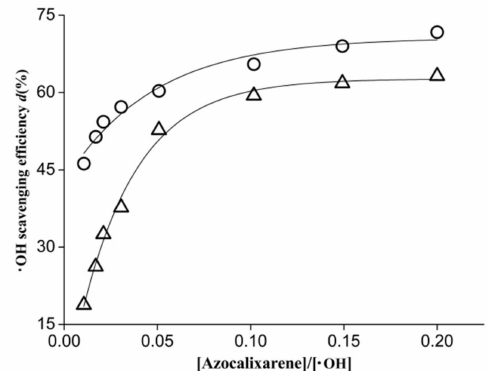
Figure 3. Hydroxyl radical scavenging efficiency as a function of the concentration ratio of [azocalixarene]/[ · OH] where cycle ( ) and triangle ( (cid:52) ) represent azocalix[4]arene derivatives 1 and (cid:35) 2,